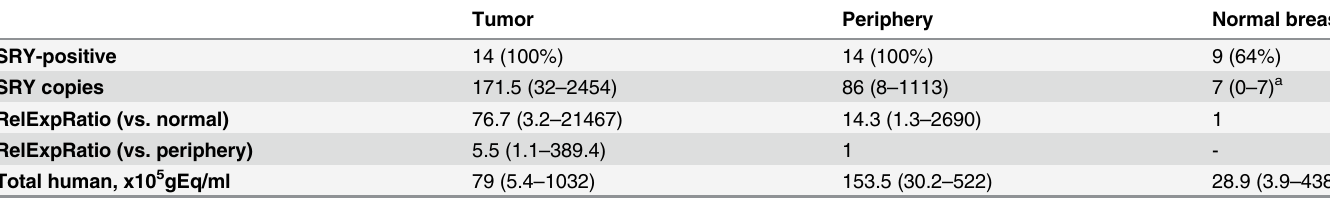
Table 2. Characteristics of fetal microchimerism for women who had given birth of at least one